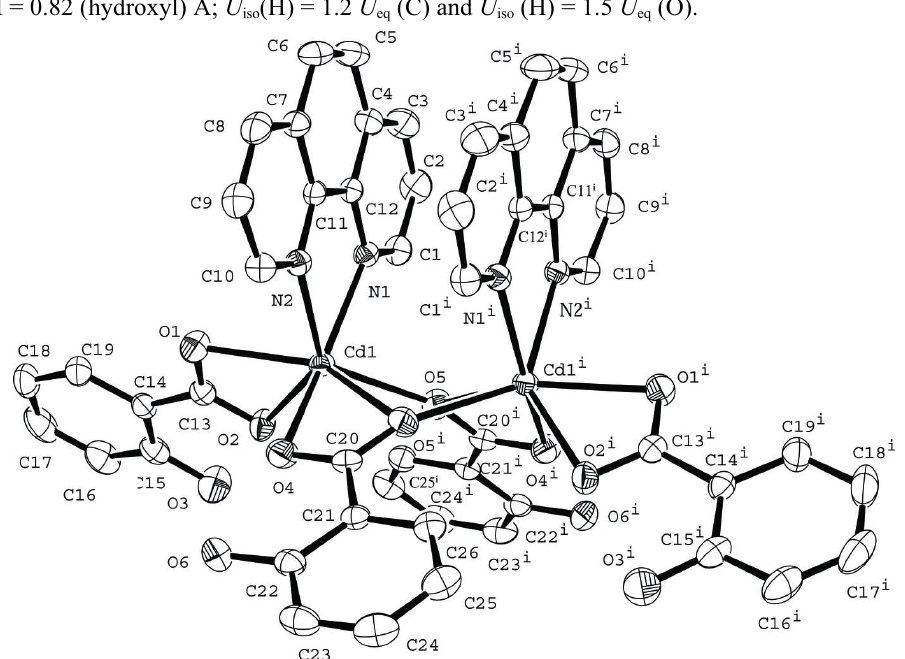
An ORTEP - 3 (Farrugia, 1997) plot of the title compound with displacement ellipsoids at the 30% probability level. All H atoms are omitted for